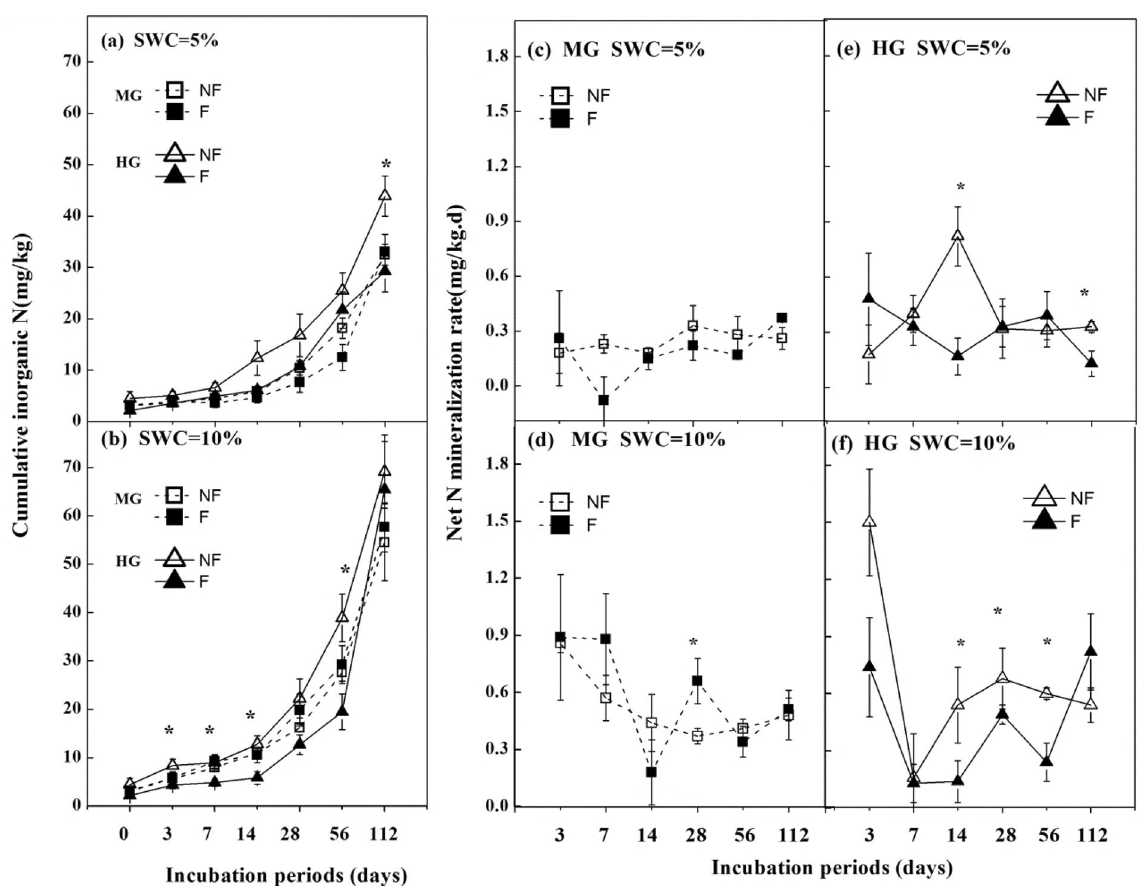
Figure 1. Soil cumulative inorganic N and net N mineralization rate (mean ± SE, n = 4) as affected by sites with different grazing intensity (MG and HG) and enclosure under different soil water contents (5% and 10%). MG moderately grazed site, HG heavily grazed site, NF non-fenced, F fenced treatment. ANOVA results are available in Table S2. Enclosure effects at a given incubation time are indicated above the data as: *** p < 0.001, ** p < 0.01, * p < 0.05.